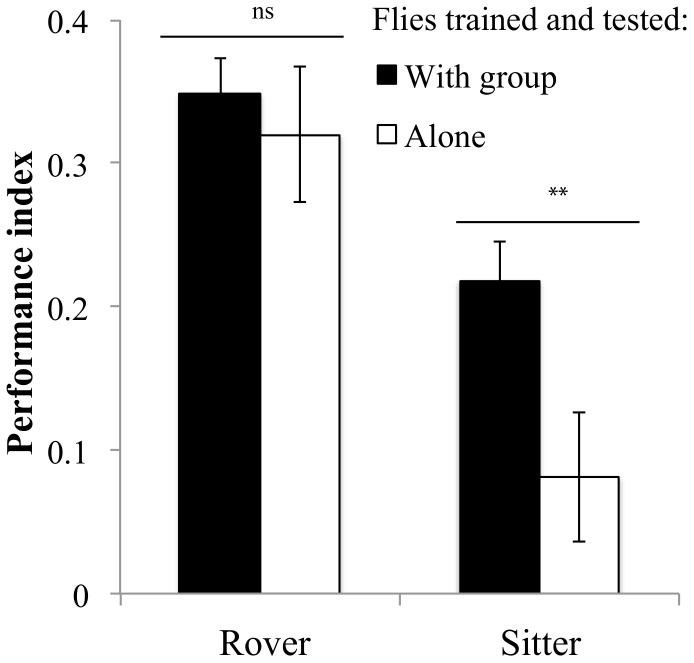
Performance of rover and sitter adult D. melanogaster when trained and tested in groups or individually.Rover: group: PI = 0.34±0.03 N = 52 PI; alone: PI = 0.32±0.04 N = 34 PI; Sitter: group: PI = 0.21±0.02 N = 52 PI; alone: PI = 0.08±0.04 N = 34. Error bars represent ±SEM. Comparison between treatments. ns: P>0.05; *: P<0.05; **: P<0.01; ***: P<0.001.